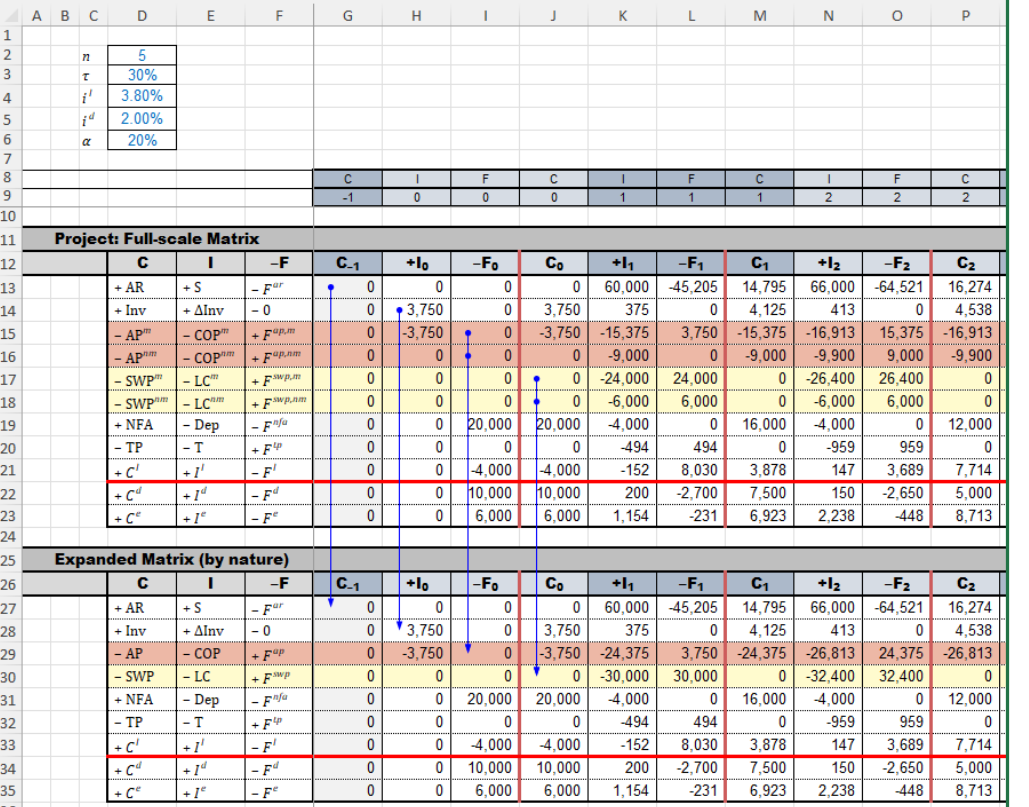
Figure 25. The strip of expanded matrices (by nature) (“SplitScreenStrip” sheet). The rows with the same color in the Full-scale Matrix are consolidated into one row of the same color in the Expanded Matrix.